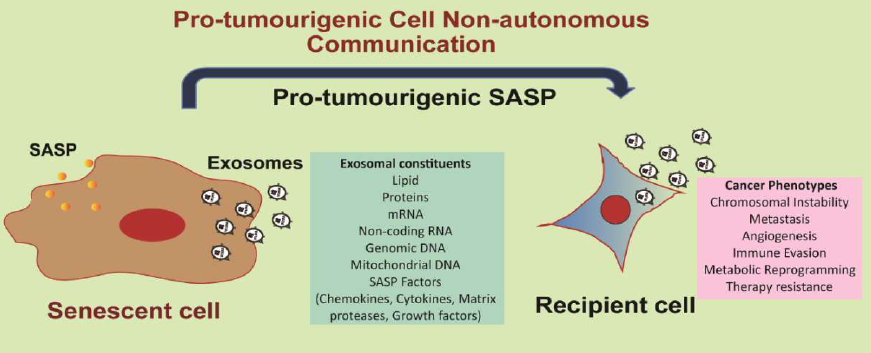
Figure 6. Senescent cell-derived exosomes serve as pro-tumorigenic SASP. Senescent cells usually secrete a myriad of factors such as cytokines, chemokines, matrix proteases and growth factors; this senescent secretome is termed as the senescence-associated secretory phenotype (SASP). Senescent cells produce enormous amounts of exosomes compared to normal cells. These exosomes constitute part of the SASP themselves, in addition to mediating transfer of SASP factors to recipient cells. Exosomal uptake in recipient cells can potentially result in increased chromosomal instability, metastasis, angiogenesis, immune evasion, metabolic reprogramming, and therapy